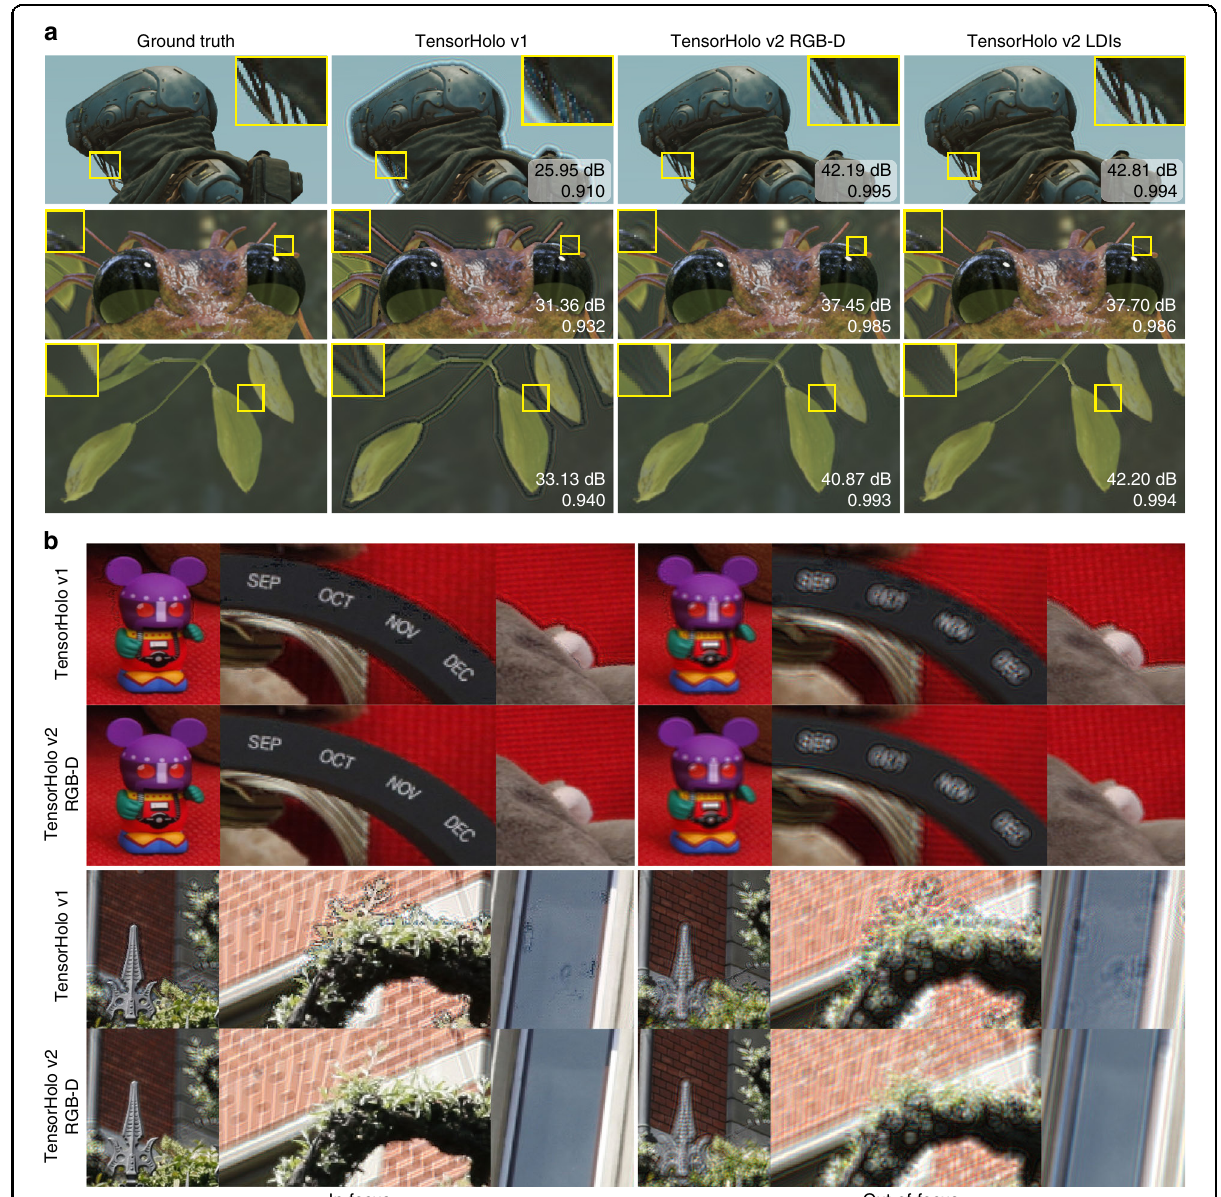
Fig. 4 Performance evaluation of TensorHolo v1, TensorHolo v2-RGB-D, and TensorHolo v2-LDIs. a Comparison of 3D holograms for computer-rendered scenes. The yellow inset marks the region of interest. b Comparison of 3D holograms for real-world captured